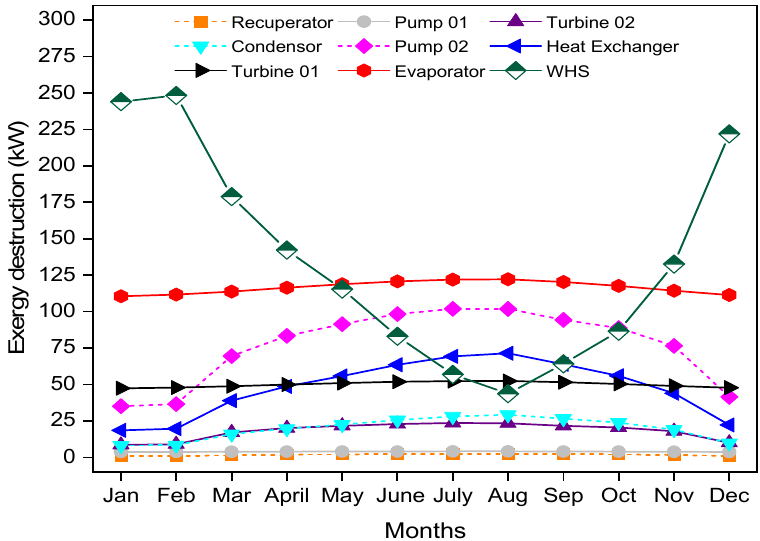
Figure 5. Exergy destruction in individual components of the system.